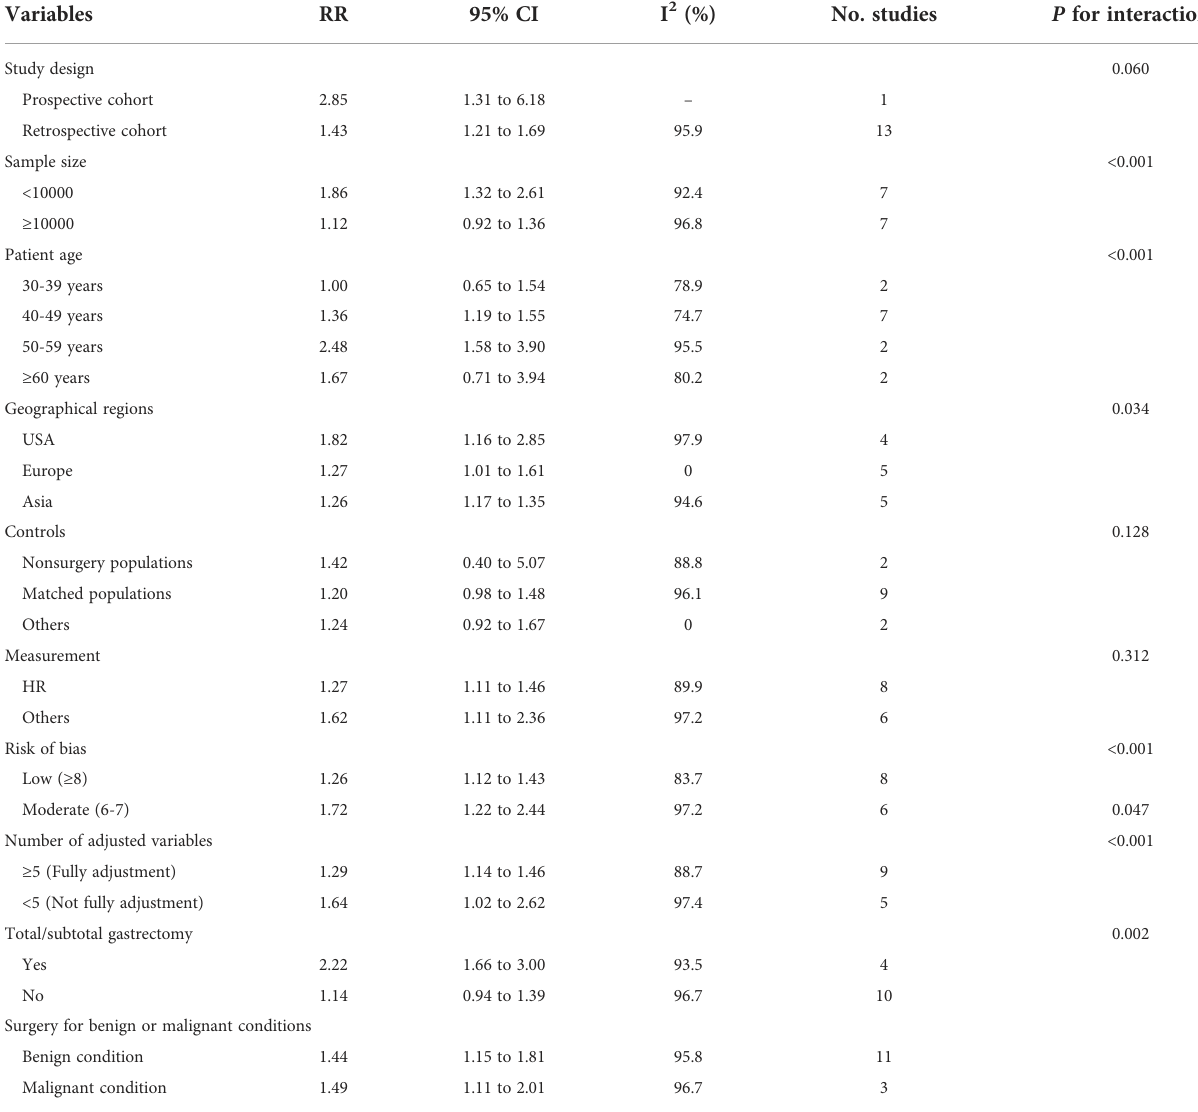
TABLE 3 Subgroup analyses for the effect of gastric surgery on risk of fracture.